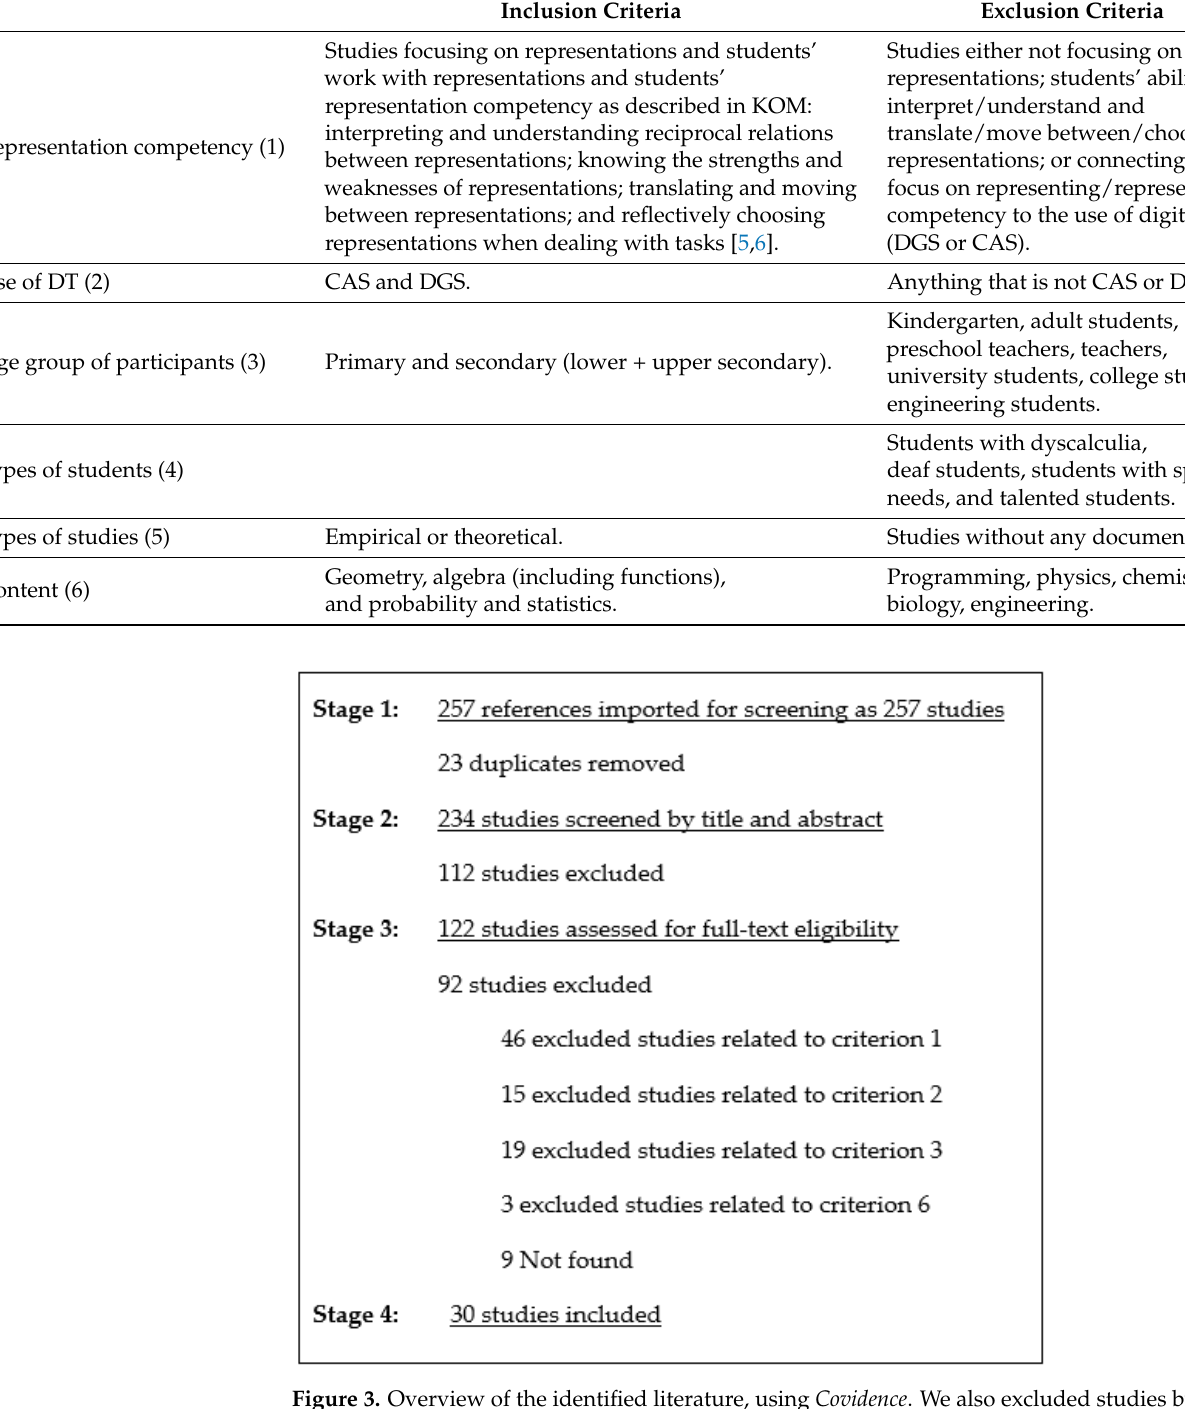
Figure 3. Overview of the identified literature, using Covidence . We also excluded studies by crite- ria 4 and 5, but we did that in stage